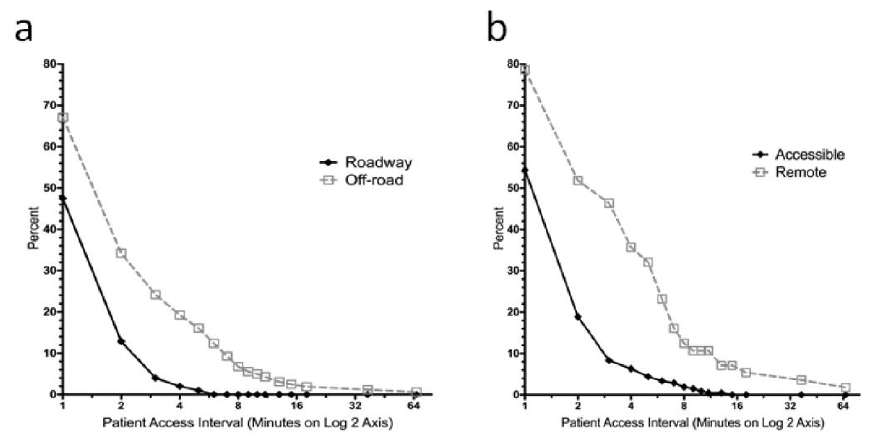
Figure 3. Comparison of the di ff erences in distribution of the length of the EMS patient access interval